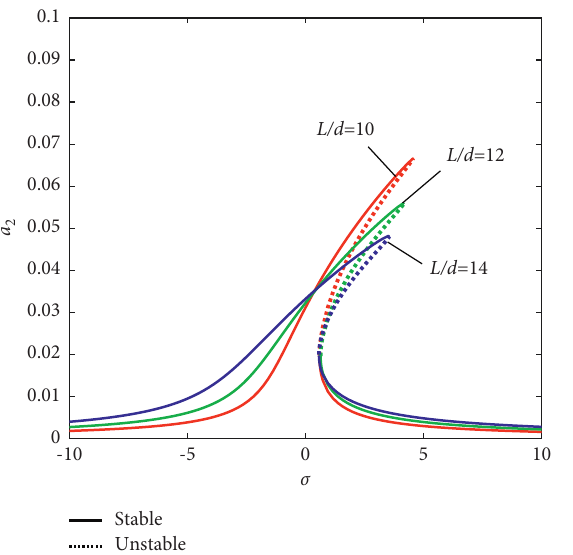
Figure 30: The effect of cutting force coefficient on frequency response curve (L/d � 10, θ � 0 ° , c � 0.01, case